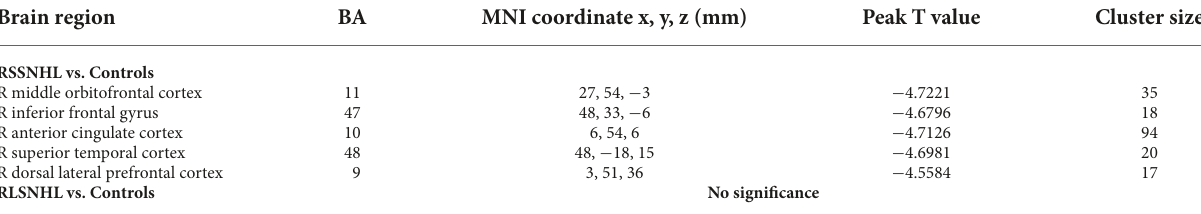
TABLE 2 Effective connections from right cerebellum lobe V among RSSNHL, RLSNHL, and Controls. Brain region BA MNI coordinate x, y, z (mm) Peak T value Cluster size